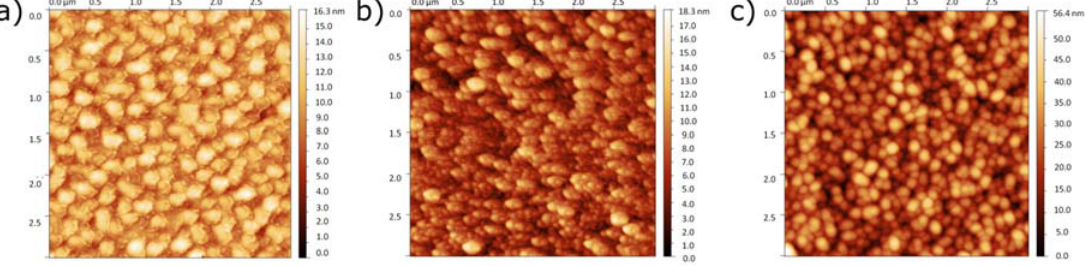
Figure 5. AFM image of ALD ZnO nanolayers with difference thickness: ( a ) 50 nm; ( b ) 100 nm and ( c ) 200 nm.